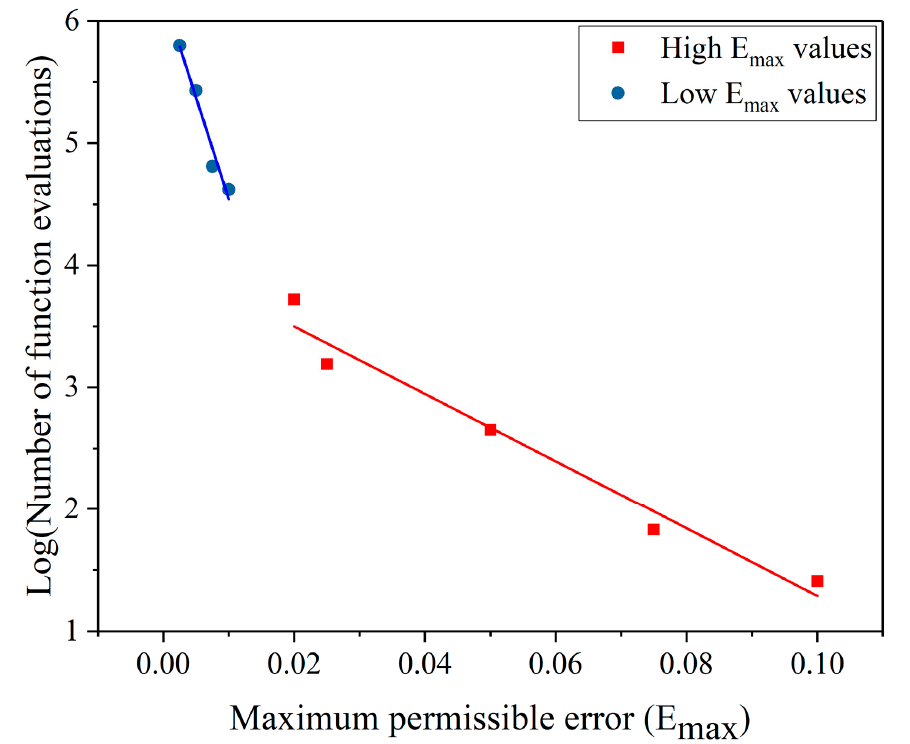
Figure 9. Number of ANN evaluations required for PSO to obtain certain maximum permissible